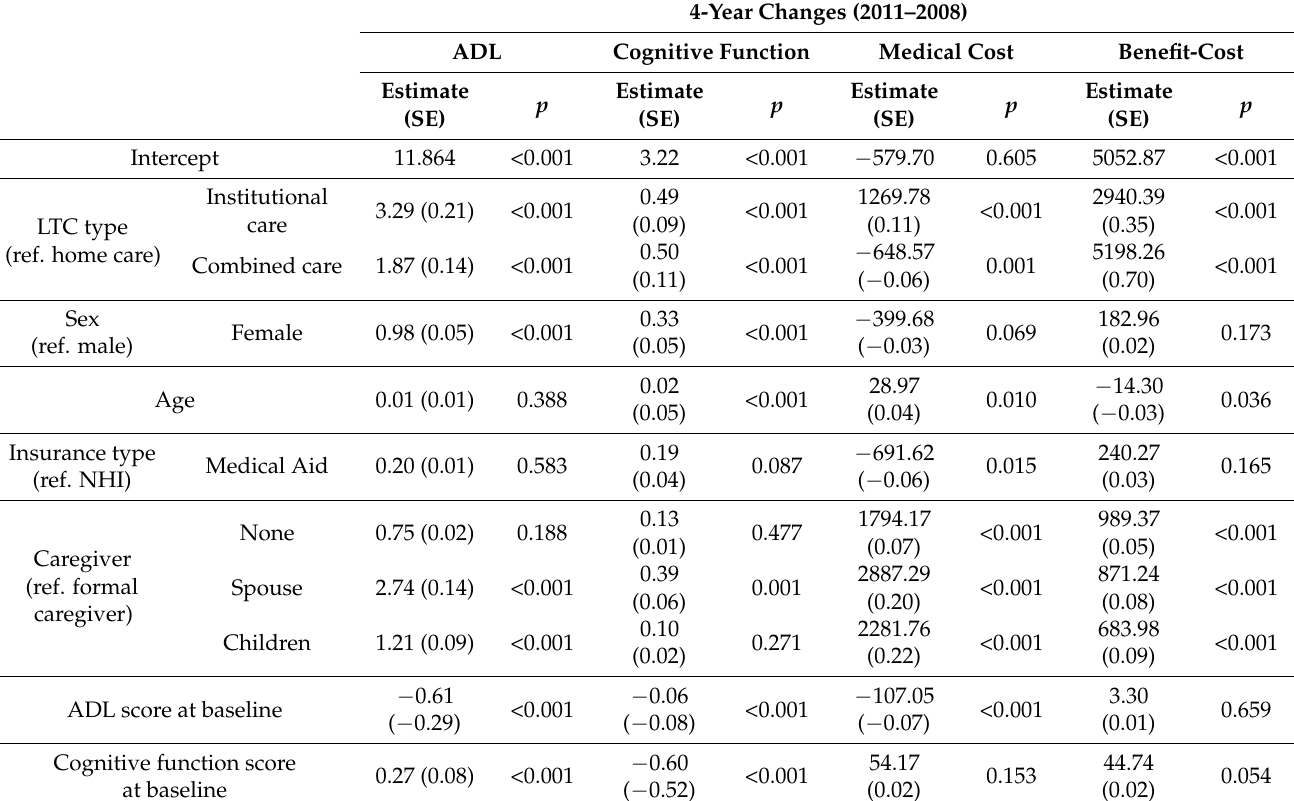
Table 4. Multiple regression analysis of the effect of LTC on 4-year changes in ADL, cognitive function, medical cost, and